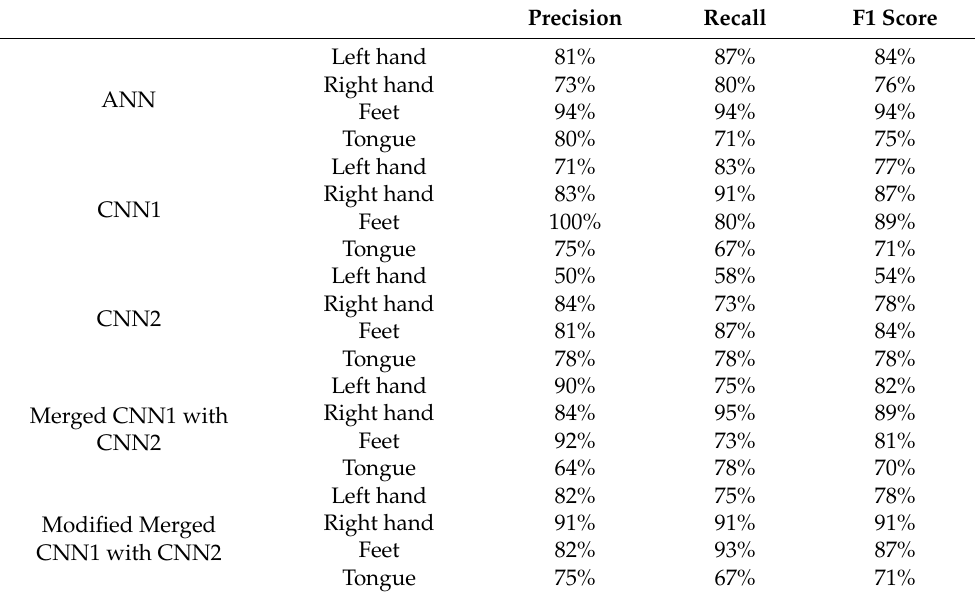
Table 1. Classification Report for the proposed methods based on (a) ANN, (b) CNN1, (c) CNN2,